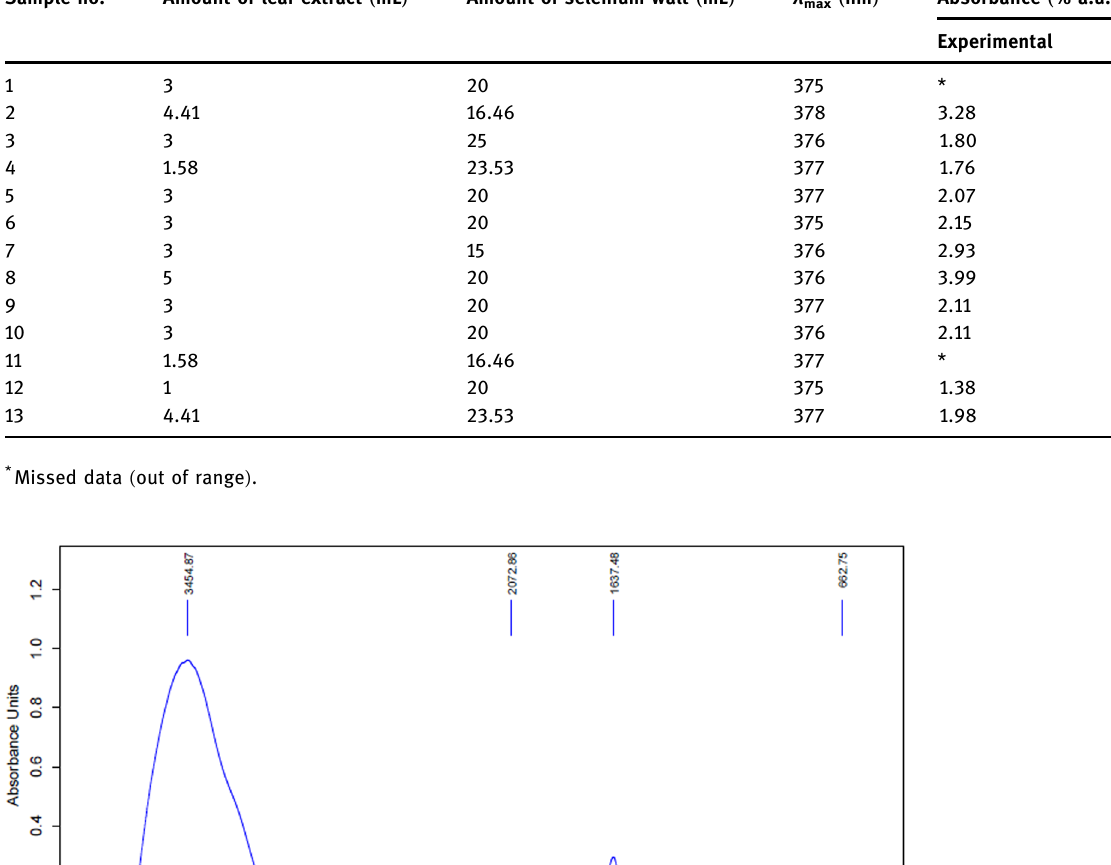
Table 1: CCD and response variables ( predicted and experimental ) for synthesis of Se NPs using walnut leaf extract Sample no. Amount of leaf extract ( mL ) Amount of selenium walt ( mL ) λ max ( nm ) Absorbance ( % a.u. )